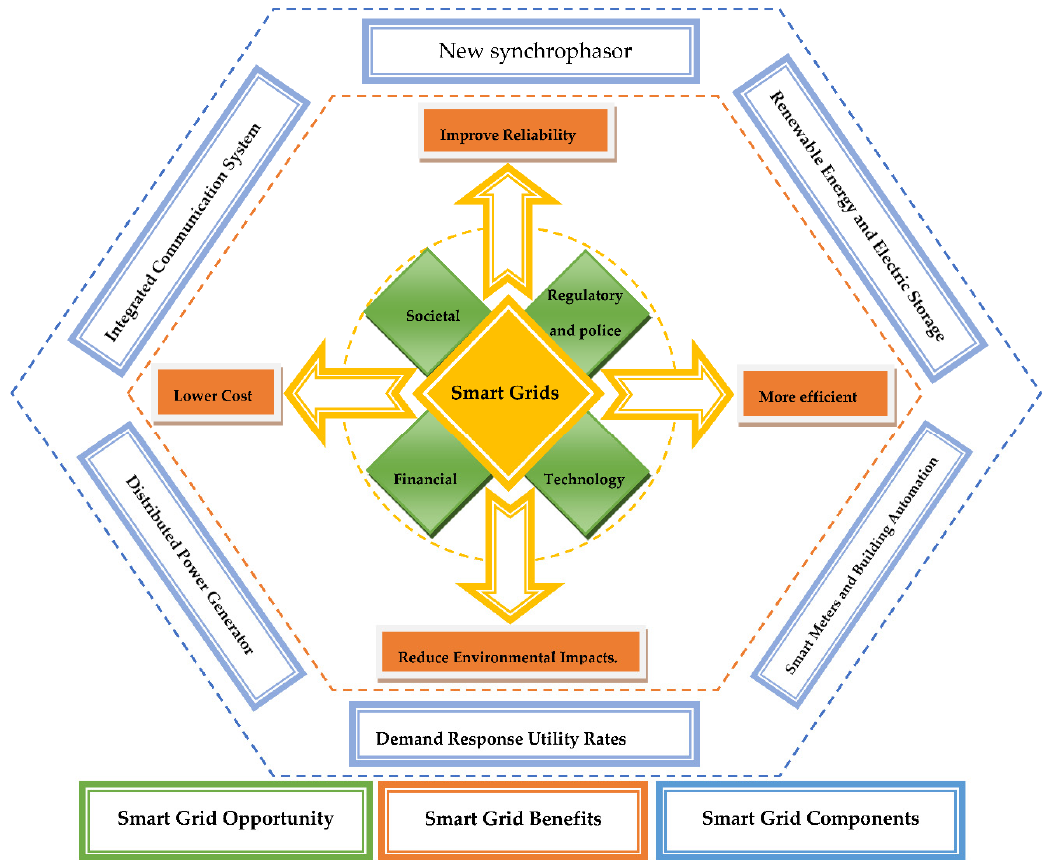
Figure 2. Smart grid opportunity, benefits, and components.